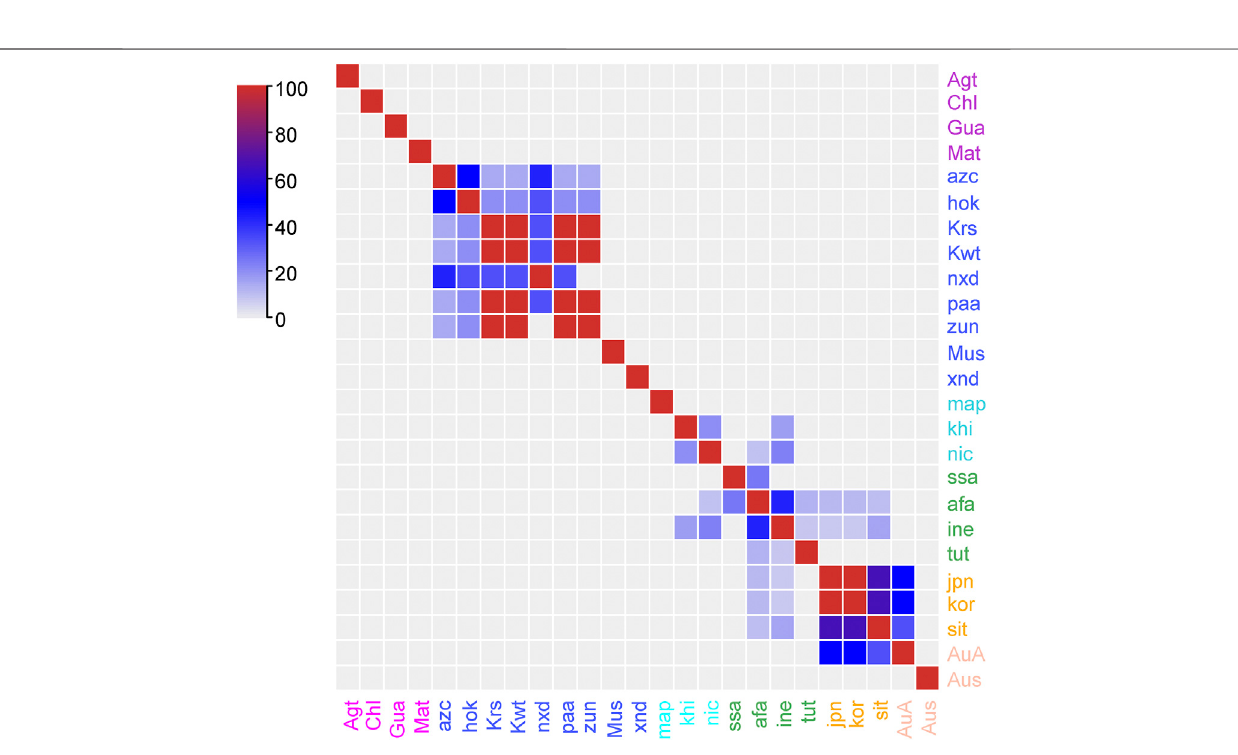
Frontiers in Pharmacology |